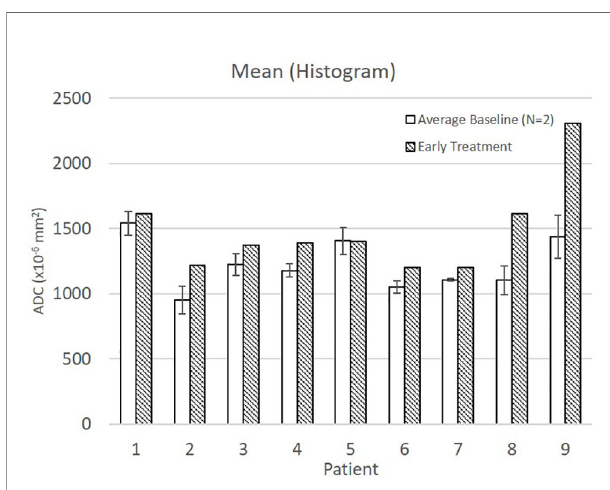
FIGURE 2 | Average and standard deviation for baseline 1 & 2 and early treatment mean